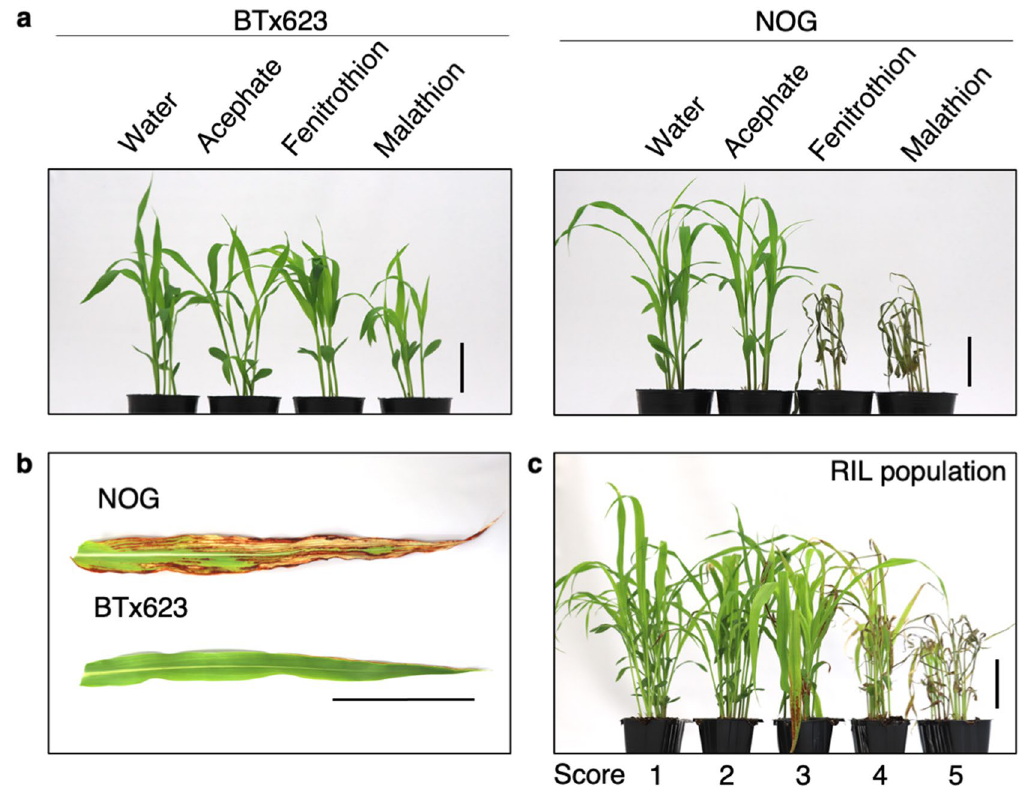
Figure 1. Phenotype of sorghum plants with organophosphate pesticide treatment. ( a ) Symptoms of BTx623 (left) and NOG (right) after acephate, fenitrothion, and malathion treatment. Scale bars; 5 cm. ( b ) OPS phenotypes of NOG and BTx623 in flag leaves, after spraying fenitrothion (1:500). Scale bars; 10 cm. ( c ) The phenotyping pool of OPS phenotypes segregating in the RIL population at the seedling stage. The mixture lines in each score with fenitrothion (1:500) spraying are displayed. Scale bars; 5